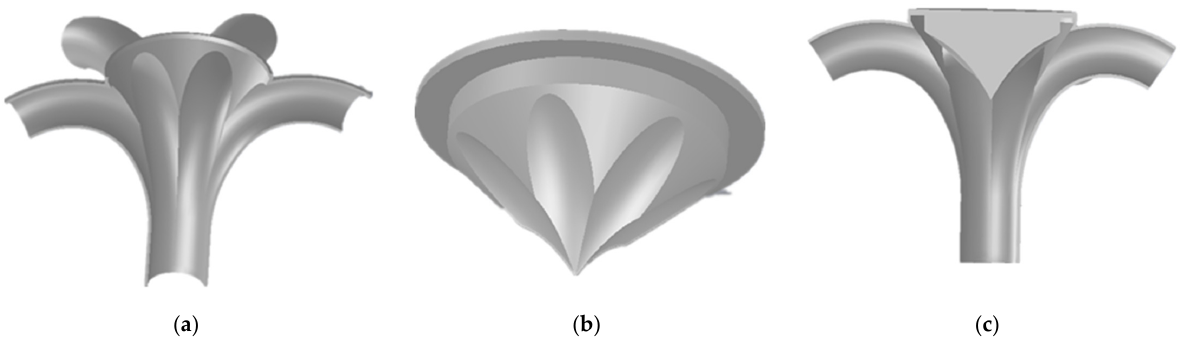
Figure 2. Internal structure diagram of distributor. ( a ) Distributor main model; ( b ) Distributor upper end cover model; ( c ) Streamlined shell cavity.